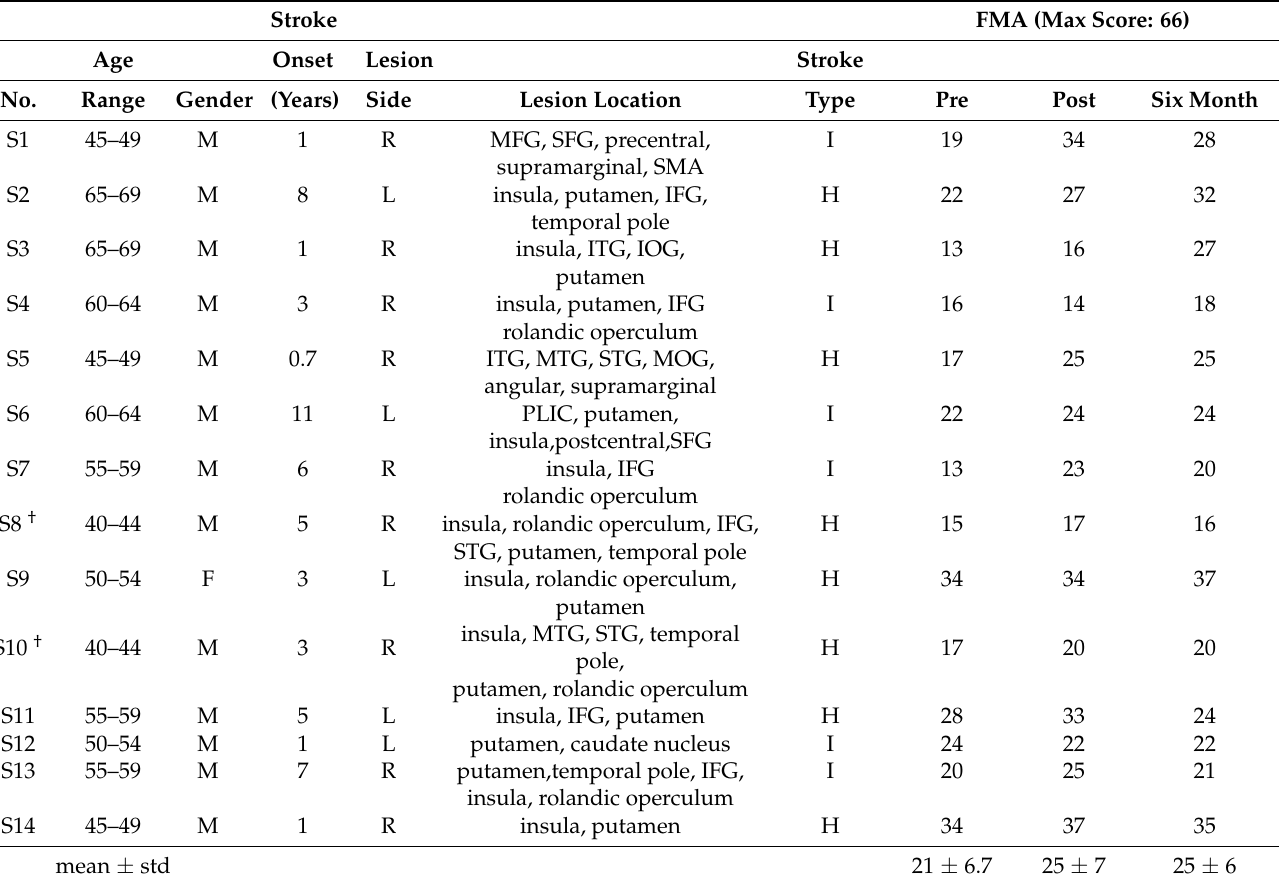
Table 1. Demographics and clinical properties of the